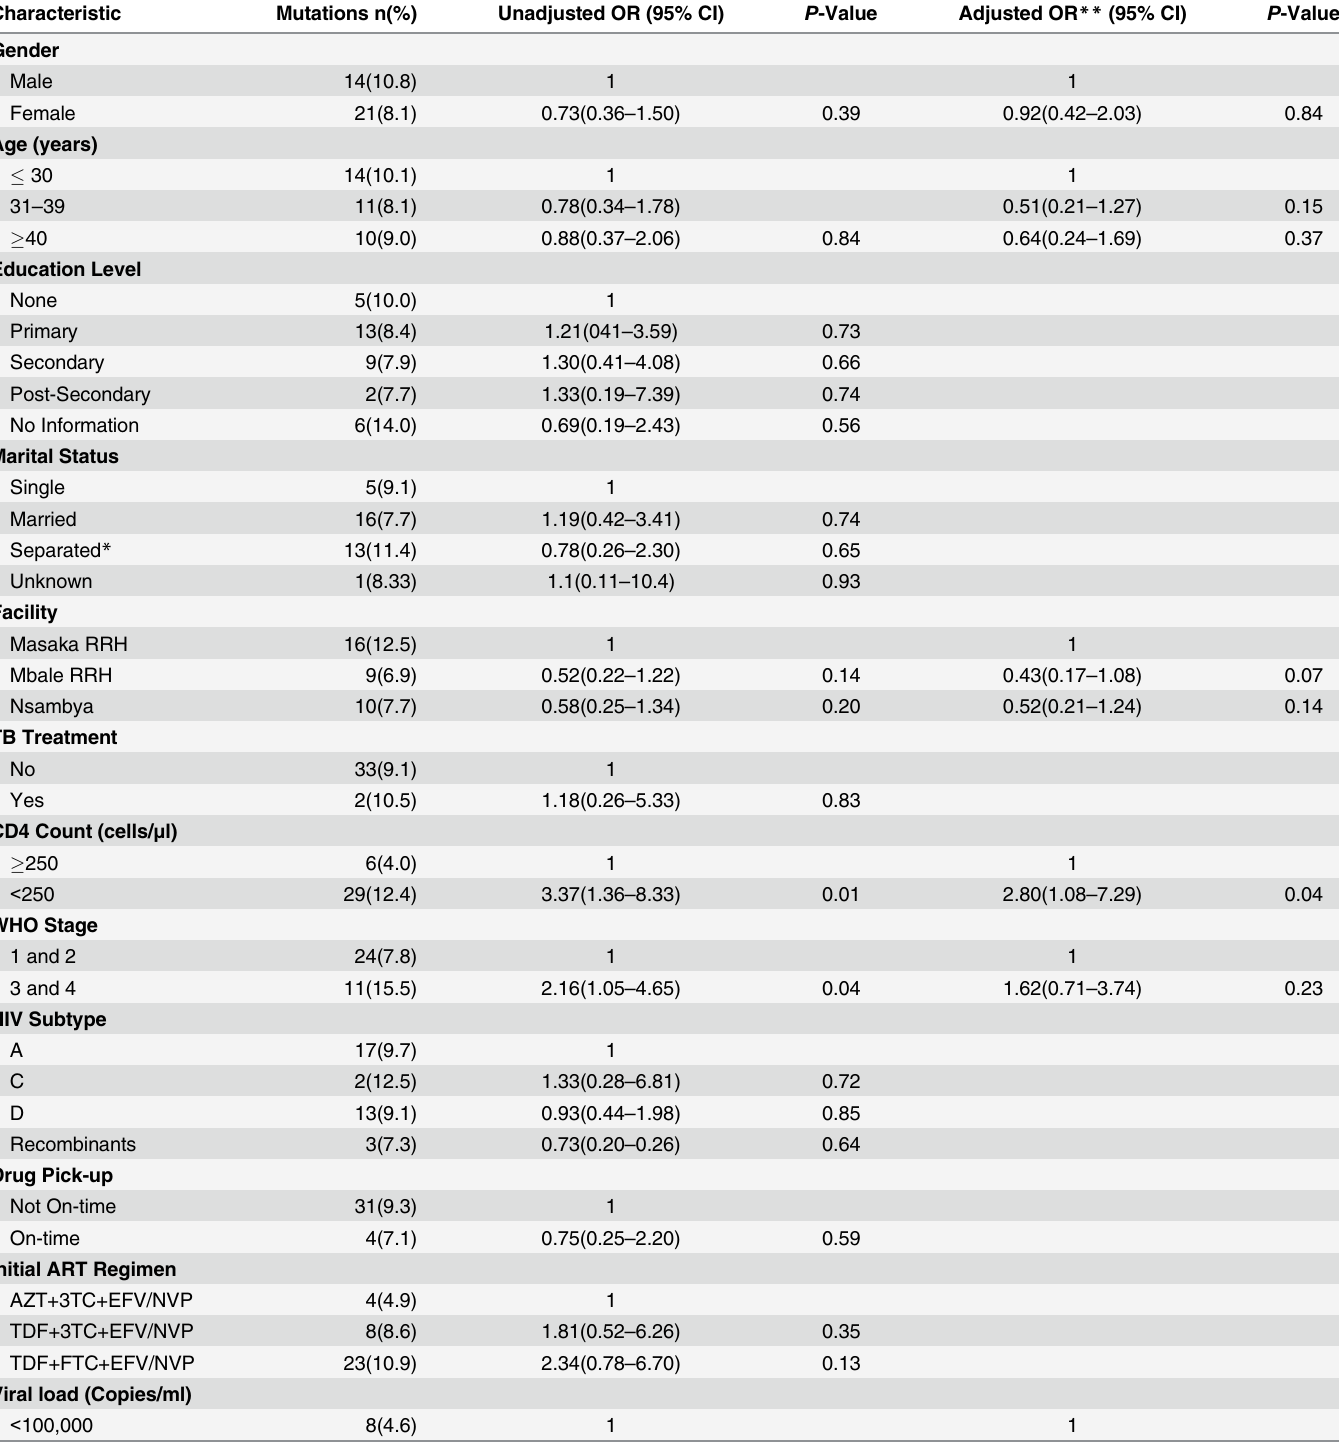
Table 4. Association between baseline patient characteristics and HIV Drug Resistance Mutations at 12 Months after ART